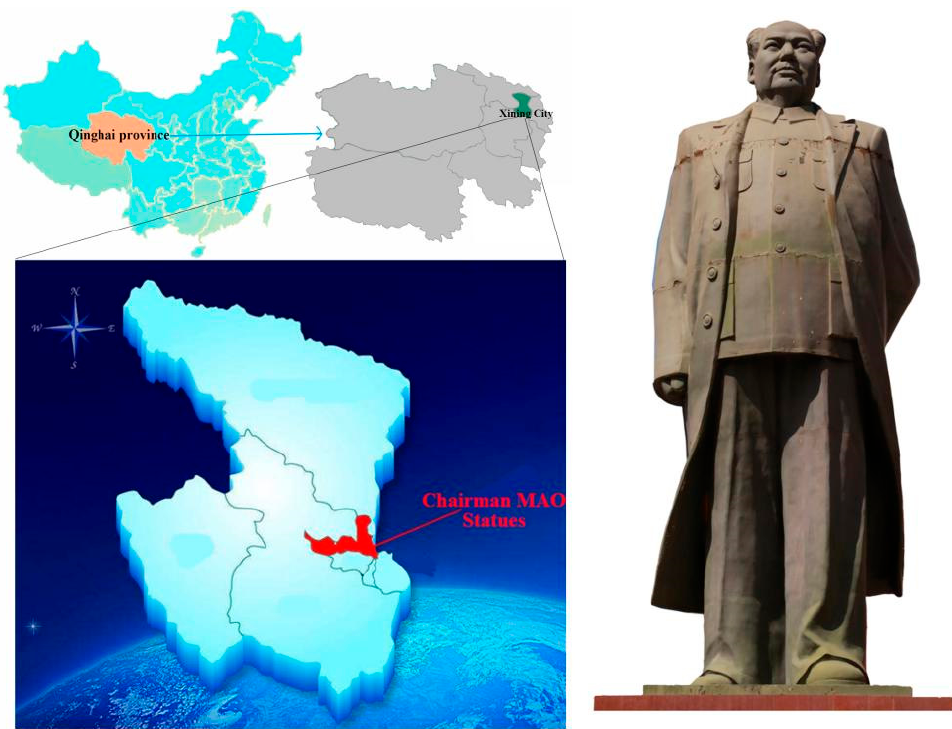
Figure 1. Location map of Chairman MAO Statue in Qinghai, China.